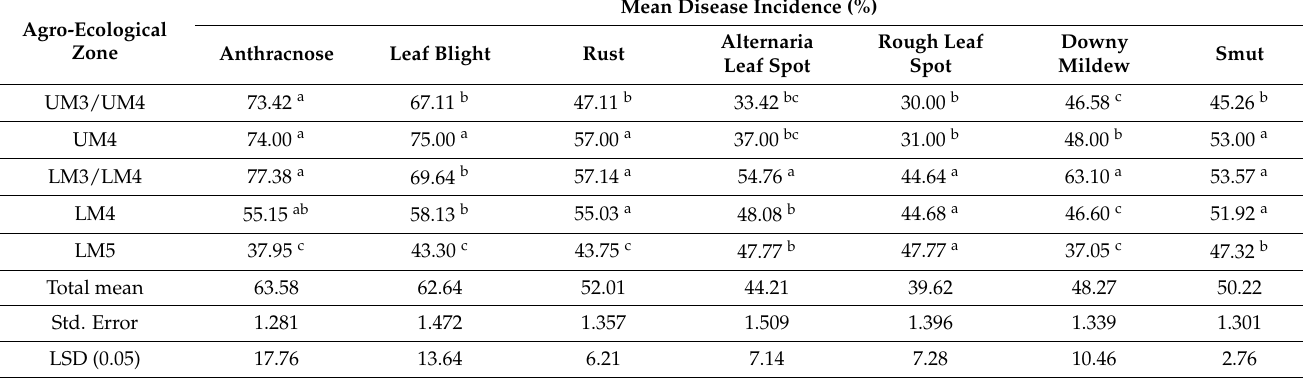
Table 3. Foliar and panicle fungal disease incidence observed in agro-ecological zones of lower eastern